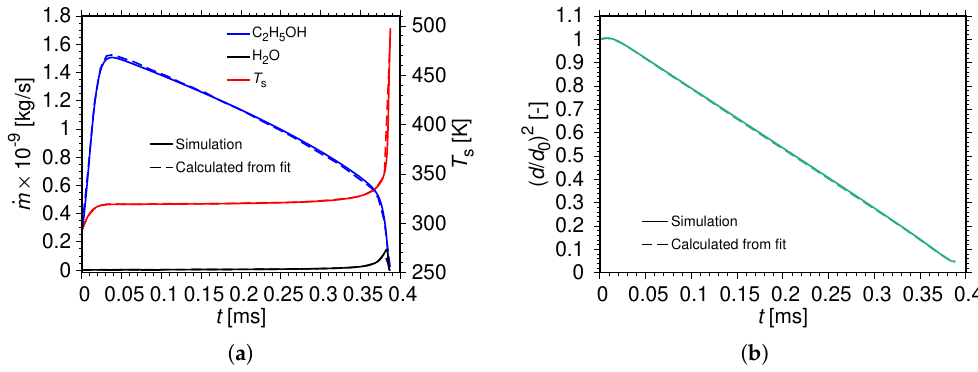
Figure 11. Initial conditions: r d,0 = 5 µ m, T l,0 = 293.15 K, p = 1 bar, u 0 = 4 m/s, T g,0 = 1200 K, Y C = 0.975, Y IN,0 = 0.025. ( a ) Mass evaporation rate and droplet surface temperature with time. 2 H 5 OH,0 ( b ) Normalized droplet surface area with